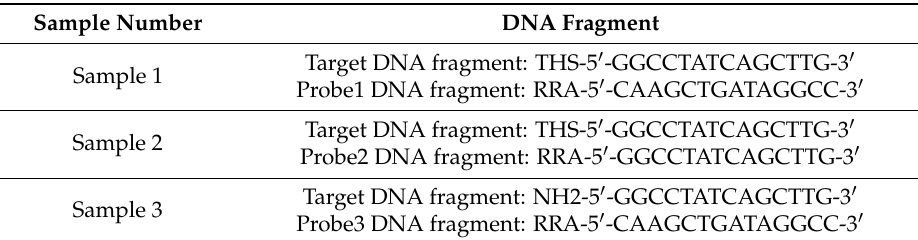
Table 2. The sequence of DNA fragment.